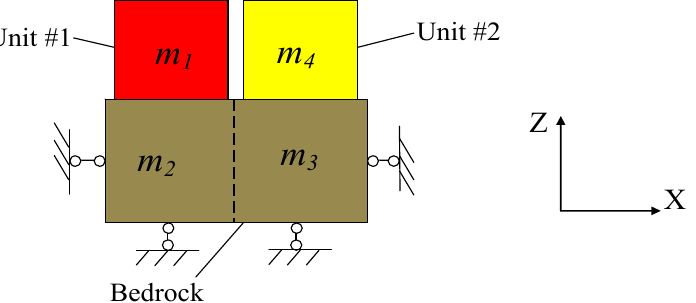
Figure 14. Simplified model of vibration transmission.